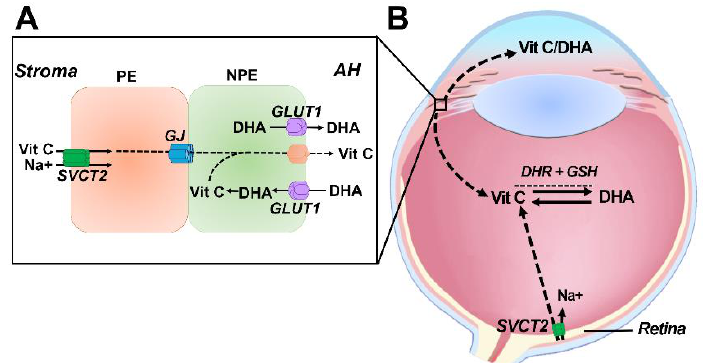
Figure 4. Molecular mechanisms involved in the secretion of vitamin C and DHA by the ciliary epithelium into the ocular humors. ( A ). Located in the apical surface of the PE cell which interfaces with the stroma microvasculature is SVCT2 which transports vitamin C resulting in the high accumulation of vitamin C in the PE. Vitamin C then moves via passive diffusion though a gap junction medicated pathway into the NPE where it then is transported out of the NPE by an unidentified mechanism into the aqueous humor (AH). Depending on the concentration gradient for DHA, GLUT1 which is located in the apical surface of the NPE cells, can either be used to transport DHA from the NPE into the AH, or DHA from the AH can be taken up into the NPE and recycled back to vitamin C. ( B ) Vitamin C is secreted into the aqueous humor and the vitreous humor. Transport of vitamin C via SVCT2 expressed in retinal pigment epithelial cells and active regeneration of vitamin C from DHA are complementary mechanisms most likely used to sustain high levels of vitamin C in the vitreous. PE-pigmented epithelium; NPE-non pigmented epithelium.